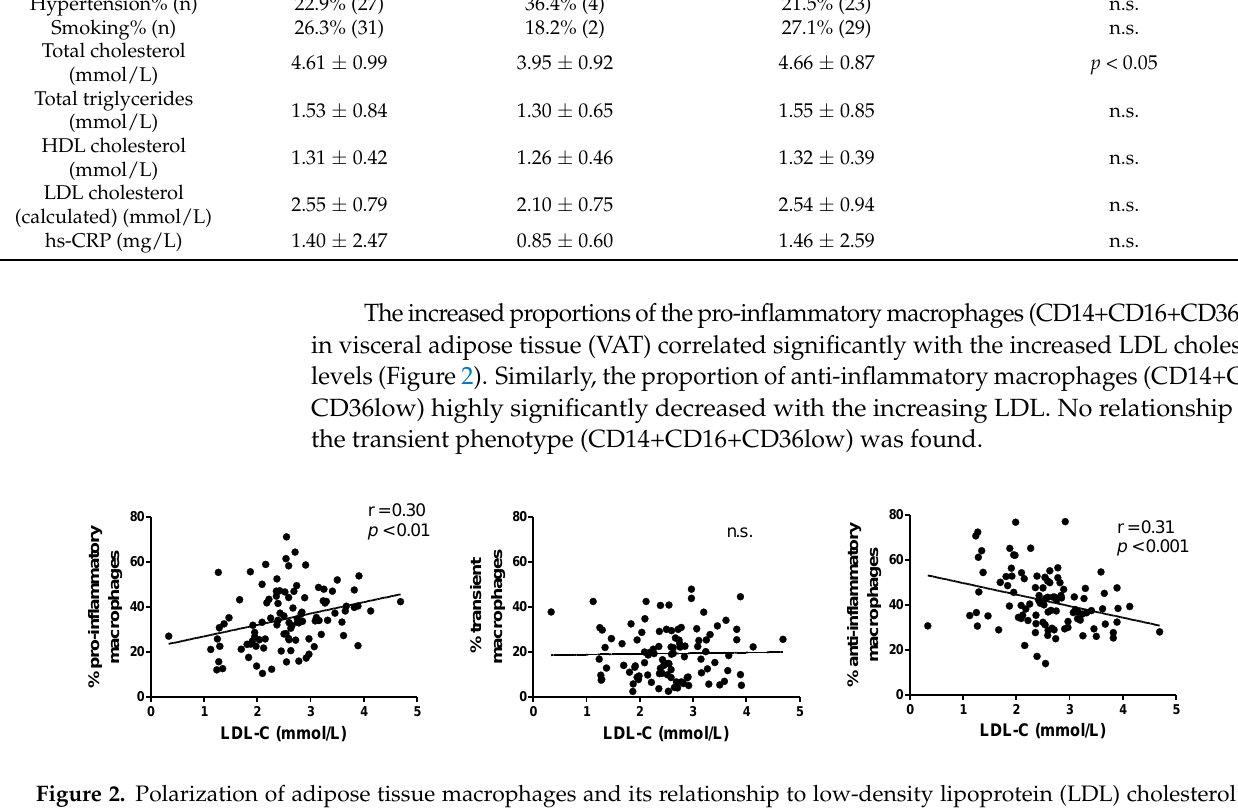
Figure 2. Polarization of adipose tissue macrophages and its relationship to low-density lipoprotein (LDL) cholesterol. Linear regression between LDL cholesterol and the percentage of pro-inflammatory (CD14+CD16+CD36high), transient (CD14+CD16+CD36low), and anti-inflammatory (CD14+CD16-CD36low) macrophages in visceral adipose tissue (VAT).